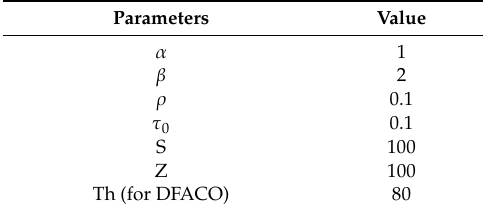
Table 1. Control parameters for ACO and DFACO.